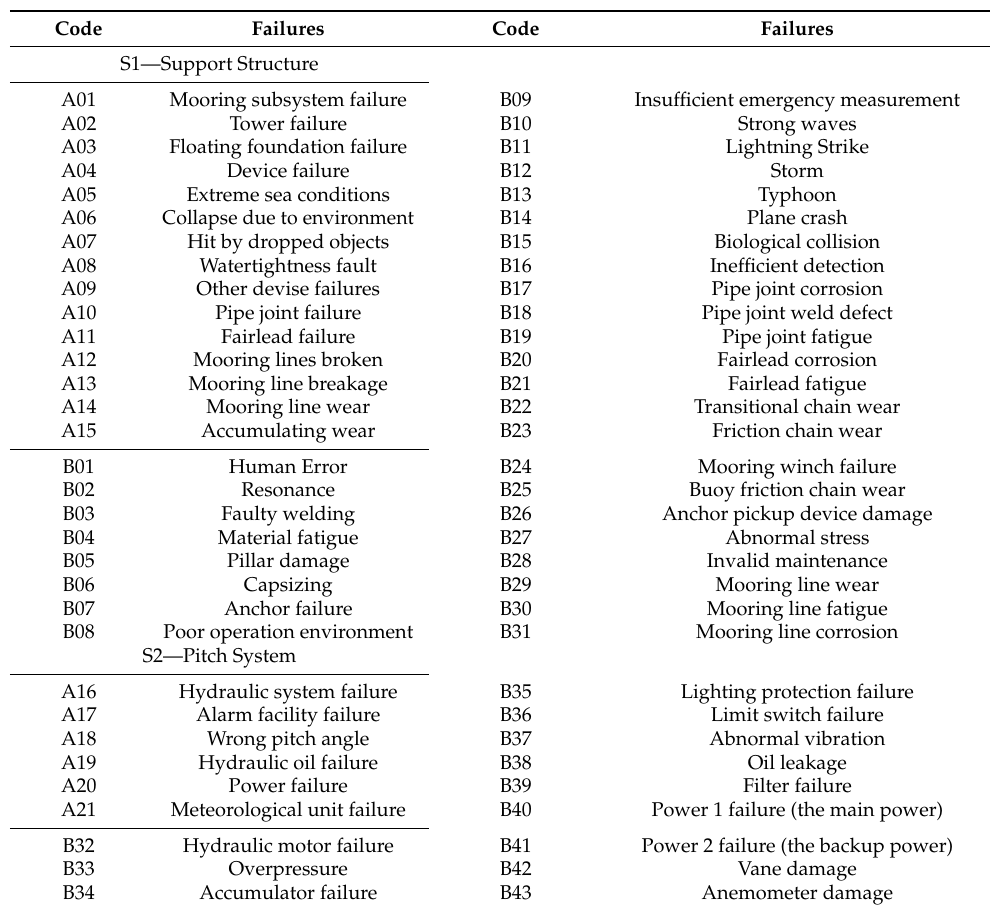
Table A4. Node definition of the BN